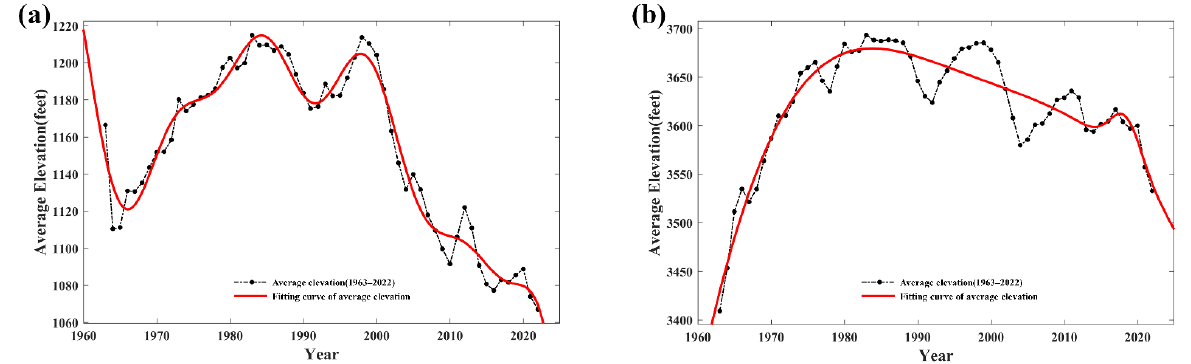
Figure 11. Reservoir average annual elevation statistics and nonlinear fitting map from 1963 to 2022. ( a ) The HD. ( b ) The GCD. Source: National Water Information System https://waterdata.usgs.gov/nwis (accessed on 20 January 2022).